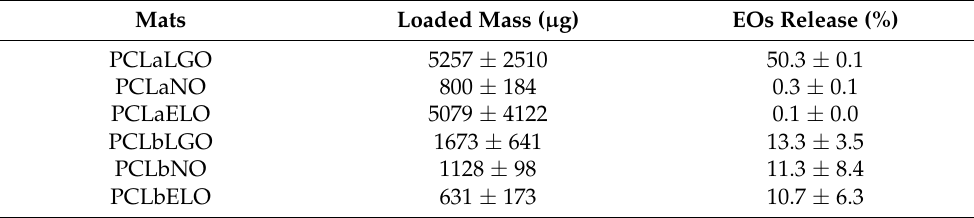
Table 4. EOs mass ( µ g) detected on film samples of 6 mm in diameter via UV-visible spectroscopy. Mass determinations for PCLaEOs were made indirectly, by measuring the absorbances of the EOs loading solution after 24 h mat immersion and of the ethanol washing bath (desorption of loosely bound EOs molecules). EOs release was mapped by GC-MS and normalized to the most important compound within the EOs, namely citral and 1,8-cineole. Data are reported as mean ± S.D. ( n = 3).